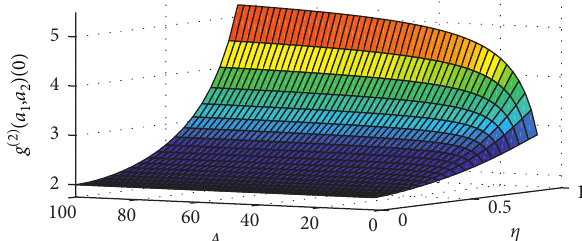
Figure 20: A plot of the normalized second-order correlation function (equation (41)) versus η and A � 100 for κ � 0 . 8, ε � 0 . 399, and n th � 0 .